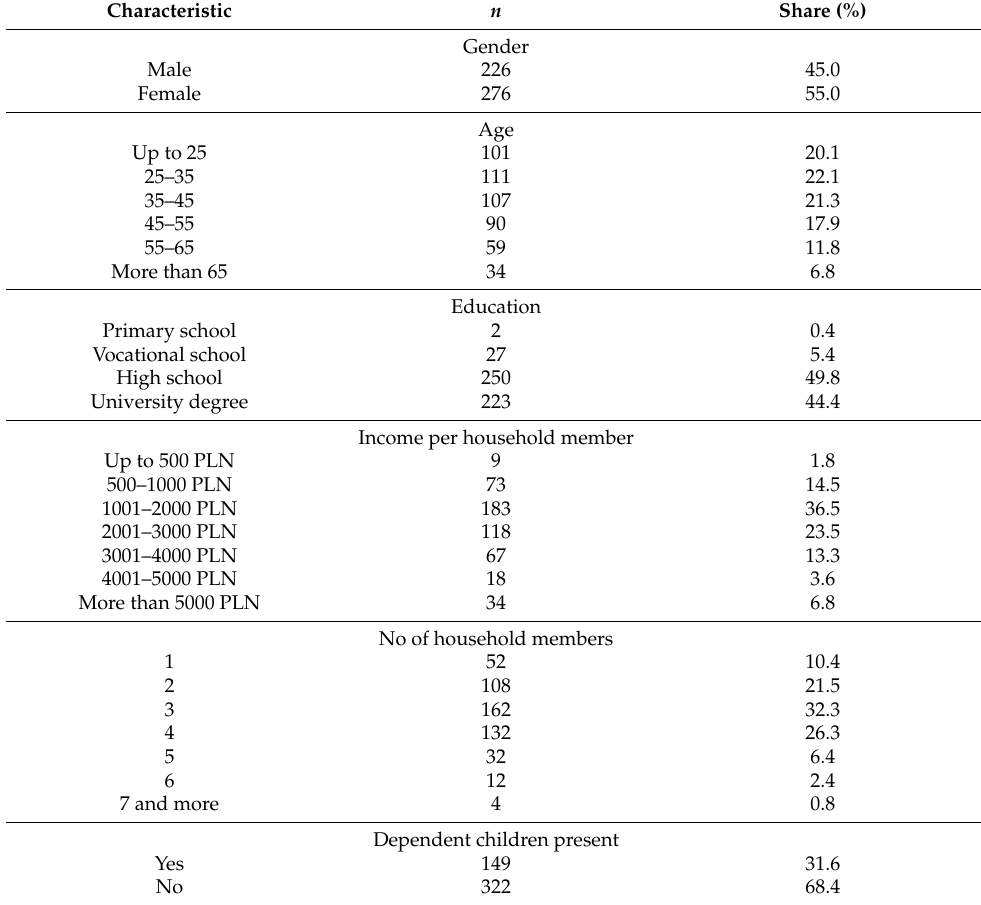
Table A1. Socioeconomic characteristics of the